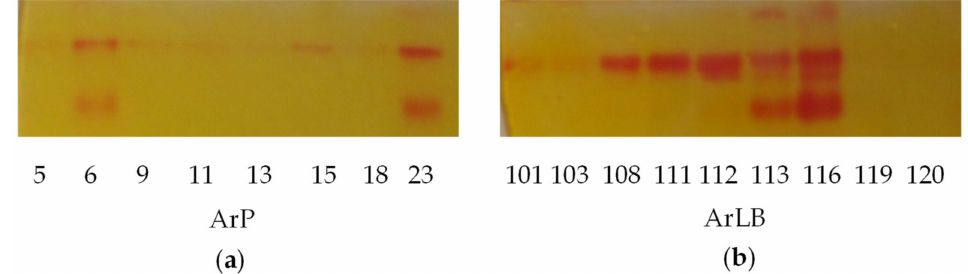
Figure 2. On-gel detection of myrosinase of the horseradish ( Armoracia rusticana ) hairy root clones, ( a ) initiated from petiole (ArP), ( b ) initiated from leaf blade (ArLB) shows visible variability. MyrB2 isoenzyme is present almost in all clones. Some hairy root clone contained three isoenzymes, which are ArLB113, ArLB116, ArP23. The detection solution contains methyl red which gives intensive red bands where the HSO 42 − is enzymatically released from the